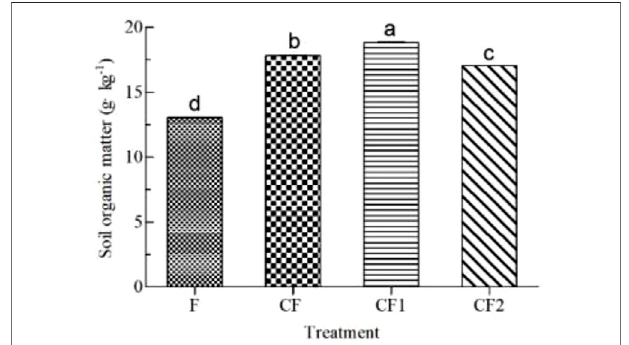
FIGURE 9 | Effect of co-application of biochar and chemical fertilizer on soil enzyme activity.